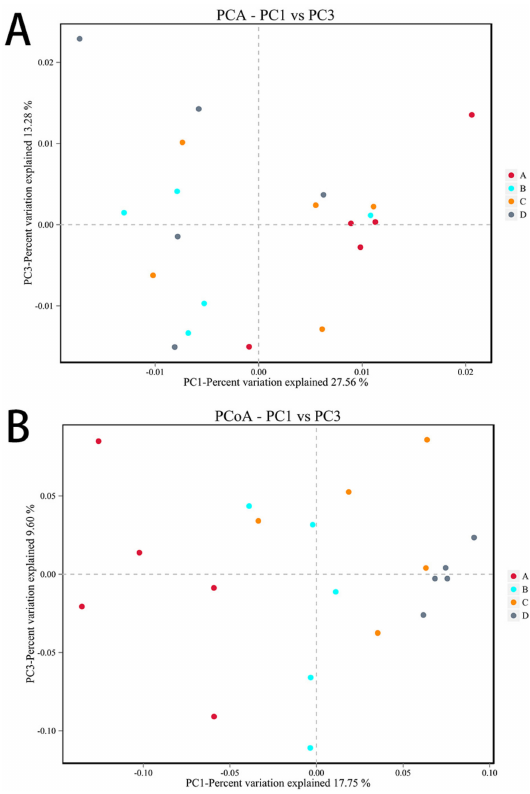
Figure 10. Beta diversity analysis. Note: Each data point represents a different sample (its color representing the group to which it belongs). The abscissa (ordinate) represents the first (second) principal component. The percentages shown are the contributions the component makes to the sample difference. A: CON group, B: L.S group, C: E. coli group, D: L.S + E. coli group. ( A ): PCA analyses ( B ): PCoA